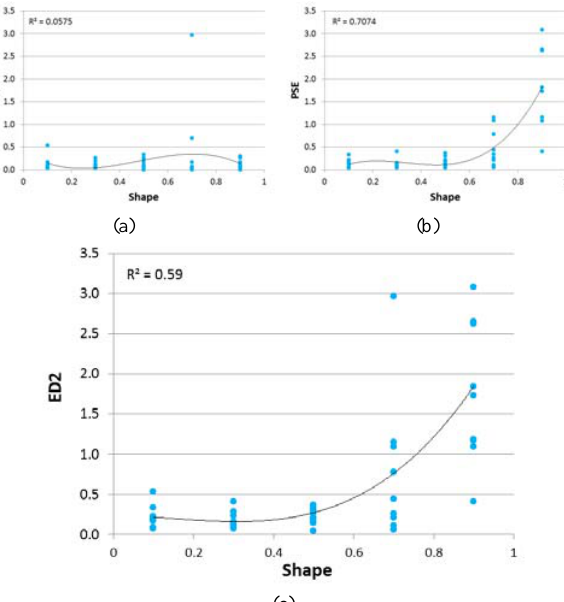
Figure 7. Scattergrams showing the variation with shape of of number-of-segmentation ratio (NSR) (a), potential segmentation error (PSE) (b) and Euclidean distance 2 (ED2) (c), for R1 and R2 subareas.